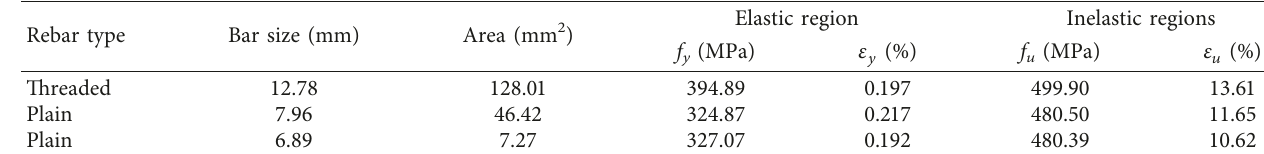
Table 3: Reinforcement bars diameter and properties.